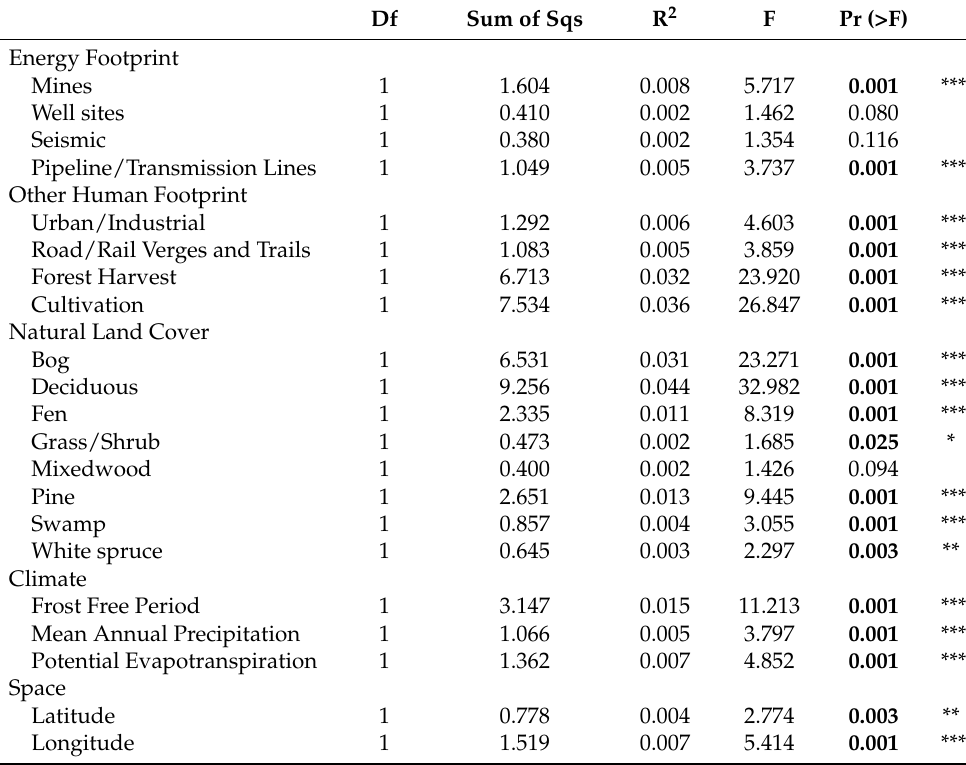
Table A5. Permutational Multivariate Analysis of Variance (PERMANOVA) results showing the significance for each natural land cover, human footprint, space, and climate variable on differences in community structure of oribatid mites for 583 site-level collection events within the oil sands region of Alberta, Canada. The total variance explained by the model was 24.5% (Pr (>F) =